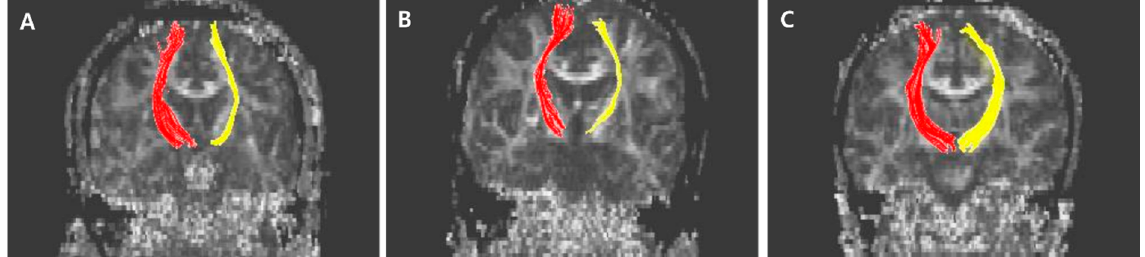
Figure 4. Representative diffusion tensor tractography images of superior thalamic radiation in typical subjects from the ( A ) CPSP group, ( B ) stroke control, and ( C ) normal control groups. The non-affected tract is shown in red, and the affected tract in yellow.